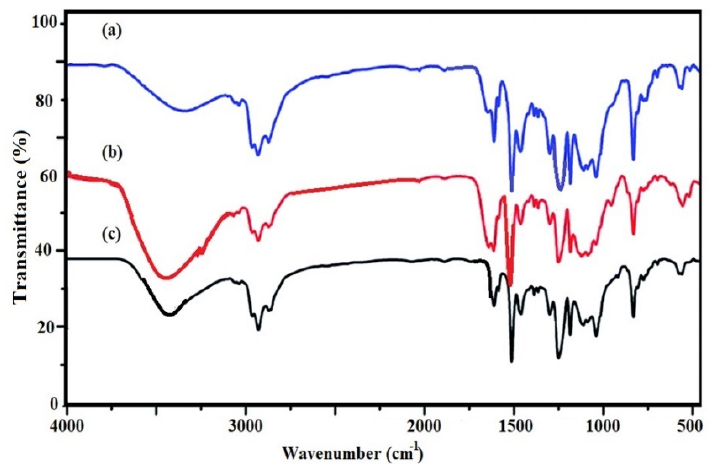
Figure 5. FTIR spectra of the cured epoxy / polyamine hardener in the presence ( a ) STHc (5 wt.%), ( b ) STHa (5 wt.%) and ( c ) without filler.